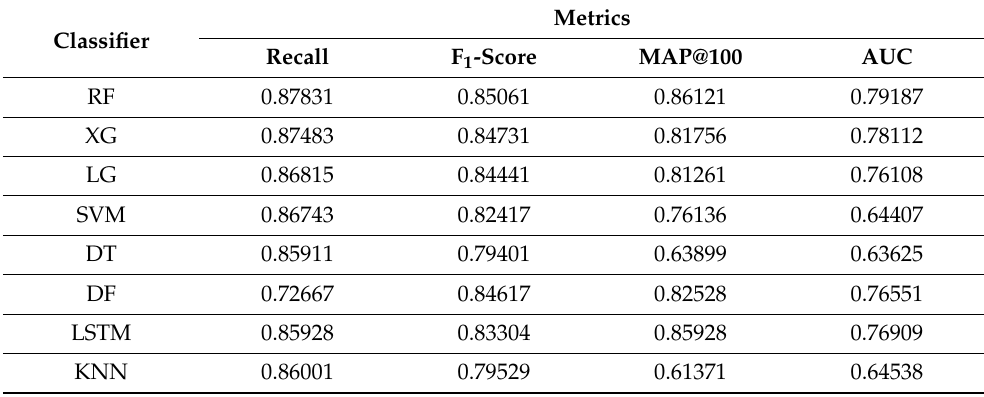
Table 5. The experimental results of 8 classifiers under feature set Y .